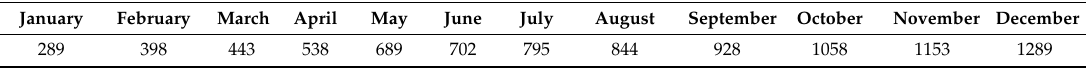
Table 8. MTBF of 2016 year after implantation of Maintenance Management